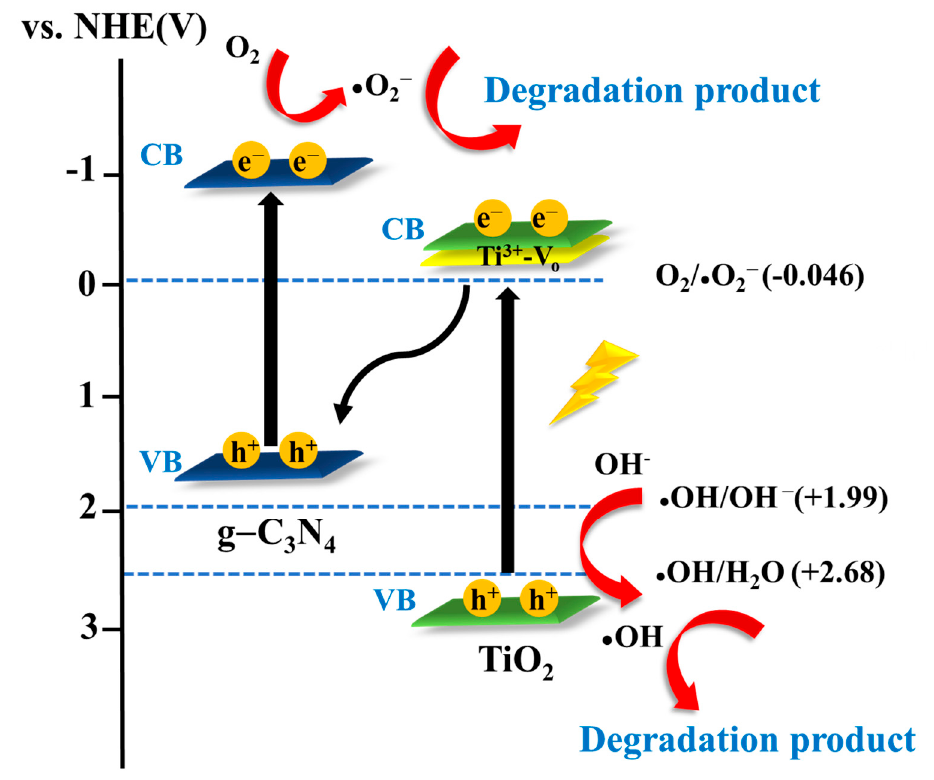
Figure 8. Photocatalytic mechanism of 0.5CNS/TiO 2 for degradation of imidacloprid.